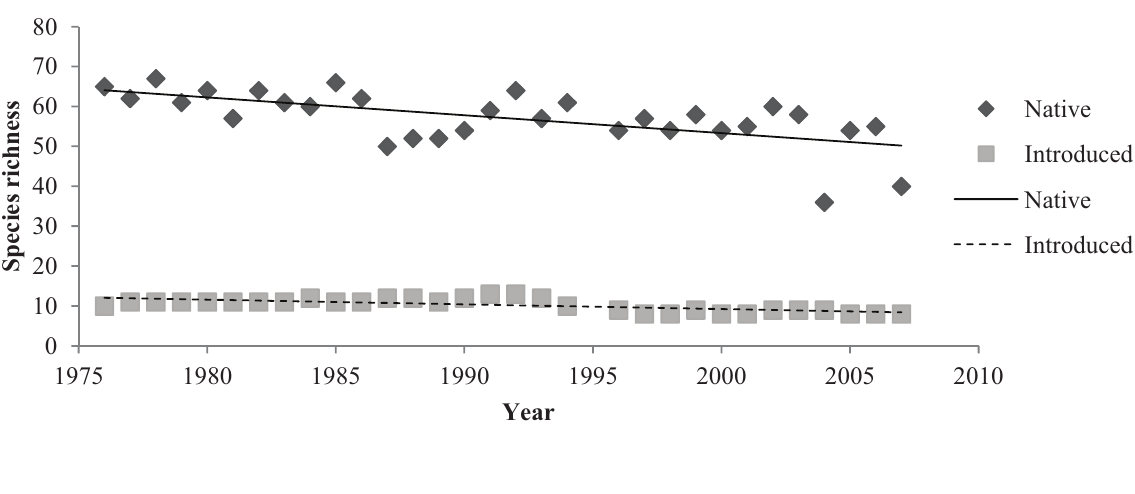
Figure 4. The annual species richness of native and introduced birds in the Adelaide City parklands from 1976 to